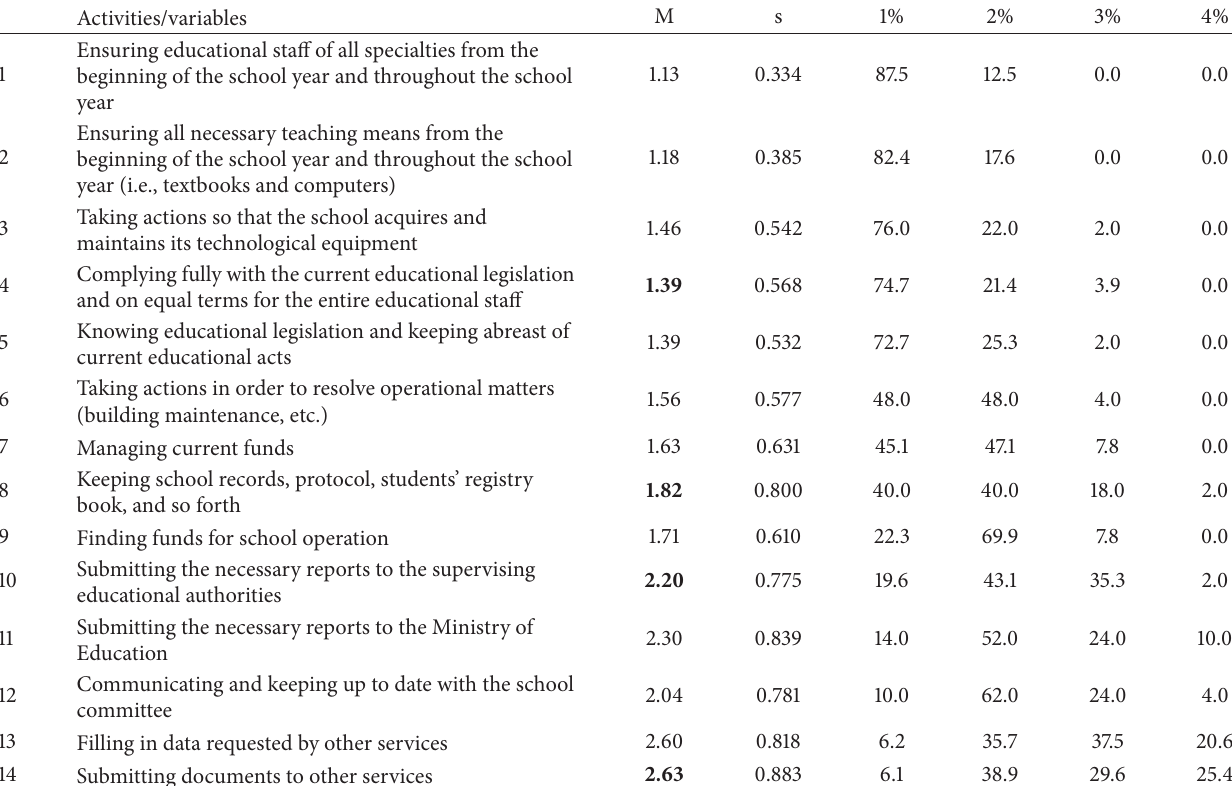
Table 4: The significance of activities related to the carrying out of administrative matters and the management of the available funds and resources in the school unit.